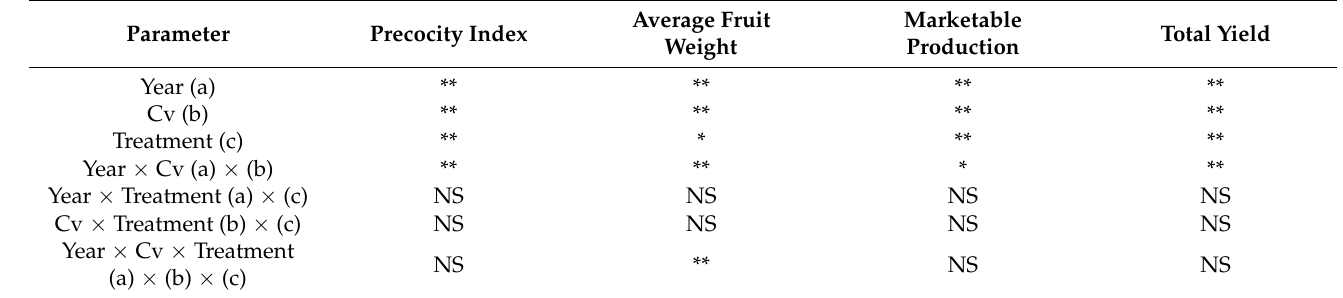
Table 9. Three-way analysis of variance (ANOVA) for the productive parameters ** = significant interaction with p < 0.01; * = significant interaction with p < 0.05; NS = not significant